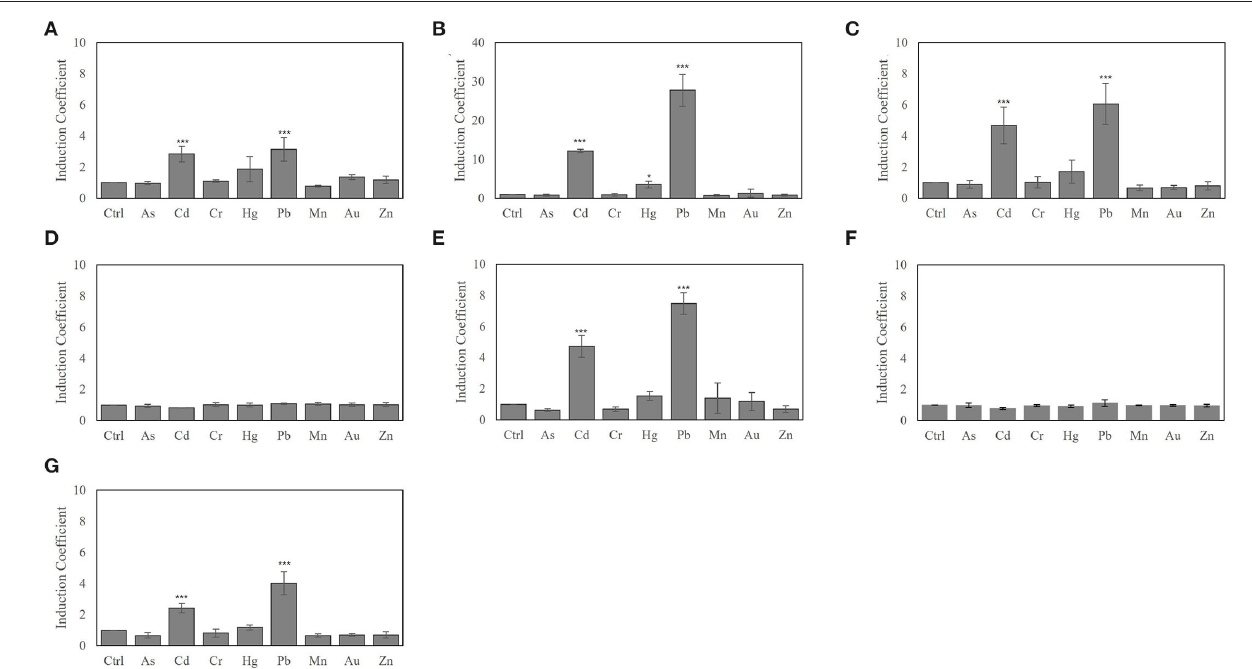
FIGURE 2 | Modulating metal selectivity of biosensors based on E. coli-zntR/copA/zntA harboring pZnt-eGFP and ZntR WT (A) , C115I (B) , C115S (C) , T117del (D) , H119R (E) , C124S (F) , and C141S (G) . The biosensors were exposed to 1 µ M of tested metal ions for 2h, and the eGFP expression levels were represented as induction coefficient values. The asterisk means the data were significantly higher than the control (Dunnett’s test, *** p < 0.001, * p <